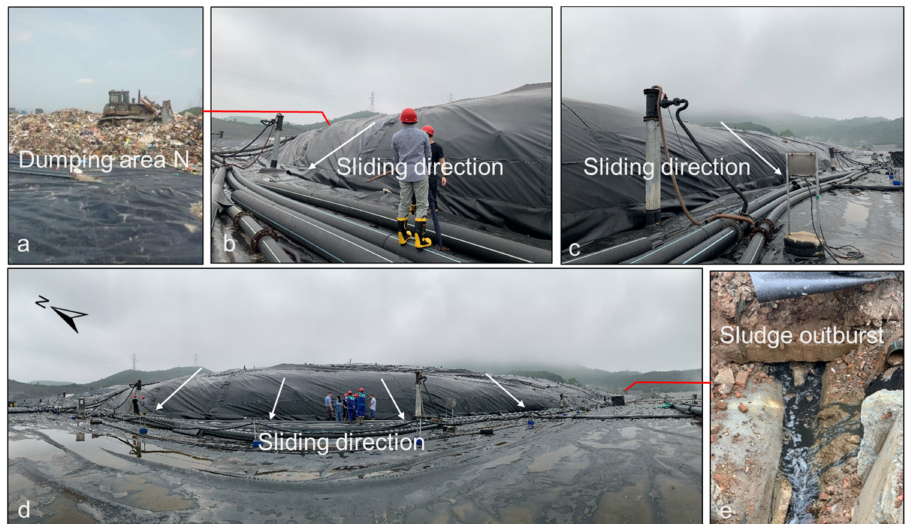
Figure 5. Images taken during field investigation: ( a ) dumping area N; ( b – d ) the sliding direction of the waste dump shown by white arrows, the viewing direction shown in Figure 3; ( e ) observed leachate and water outbursts with sludge in the southwest corner of the landfill, whereby the red lines indicate the positions of ( a , e ).